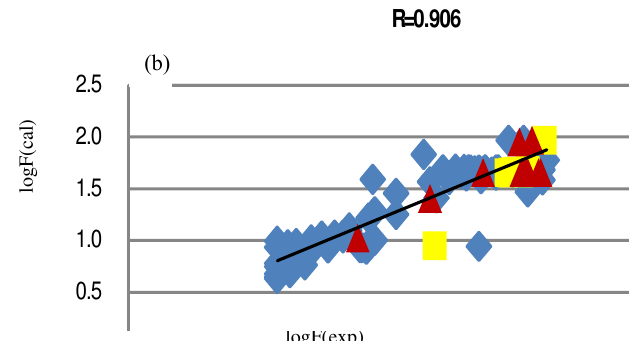
Figure 2. Plot of the (a) GA-MLR and (b) GA-ANN calculated logF against experimental value for all drugs in data set.